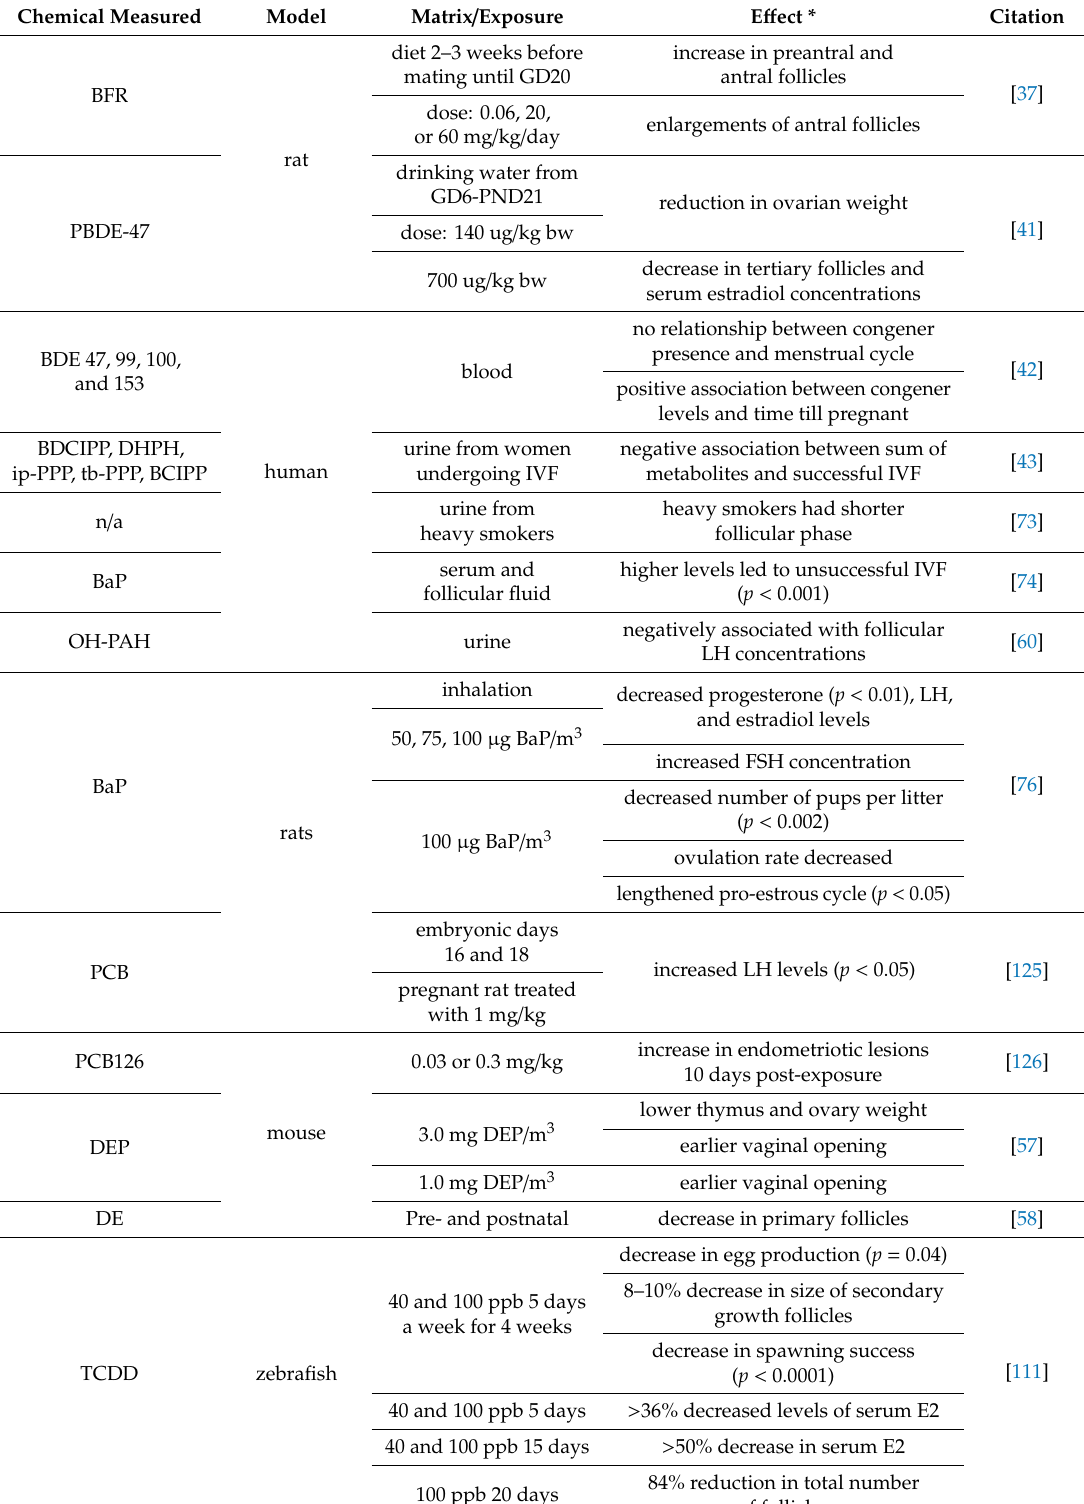
Table 2. Summary of Inhalable Endocrine-Disrupting Chemicals and Female-Specific E ff ects in Multiple Animal